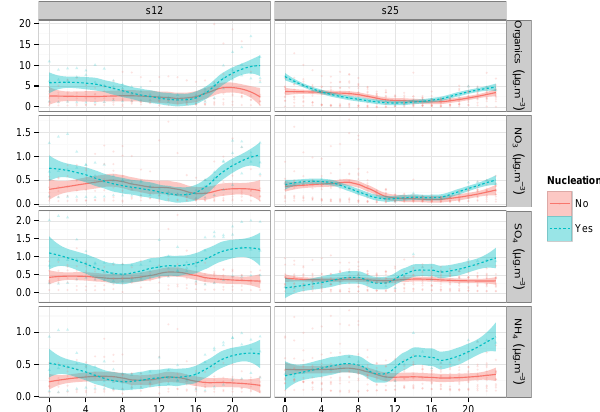
Figure 2. Average diurnal pattern of organics, nitrate, sulfate and ammonium concentrations as well as the measured data on nucle- ation and non-nucleation days at s12 and S25. Shaded areas repre- sent the 95% confidence interval in the mean. Data include 5 and 51 nucleation and non-nucleation days